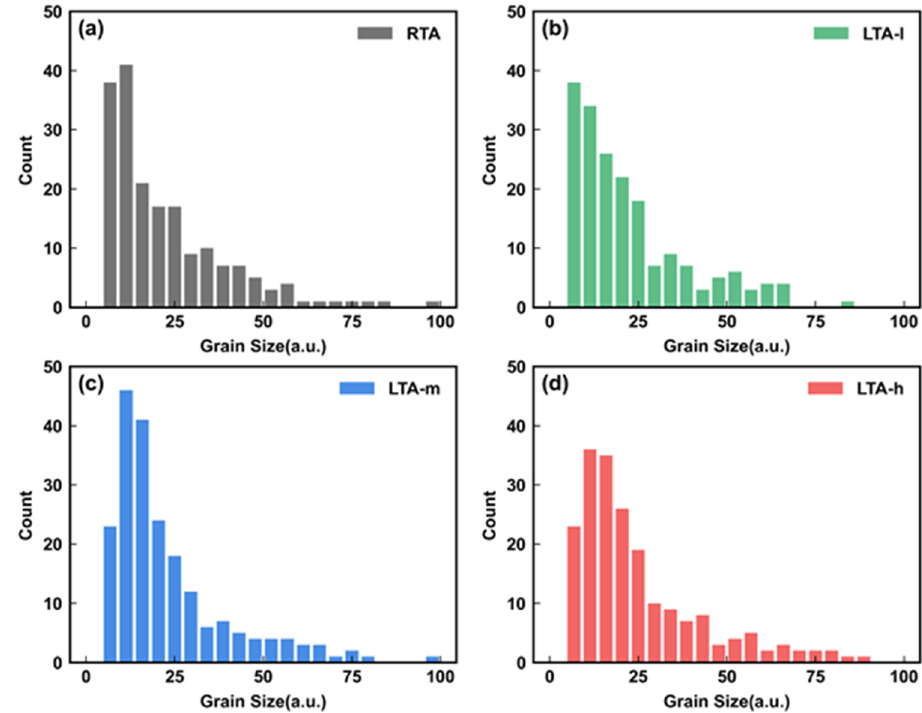
Figure 5. The statistics of grain size distribution with different thermal conditions, ( a ) RTA, ( b ) LTA-l, ( c ) LTA-m, and ( d ) LTA-h.